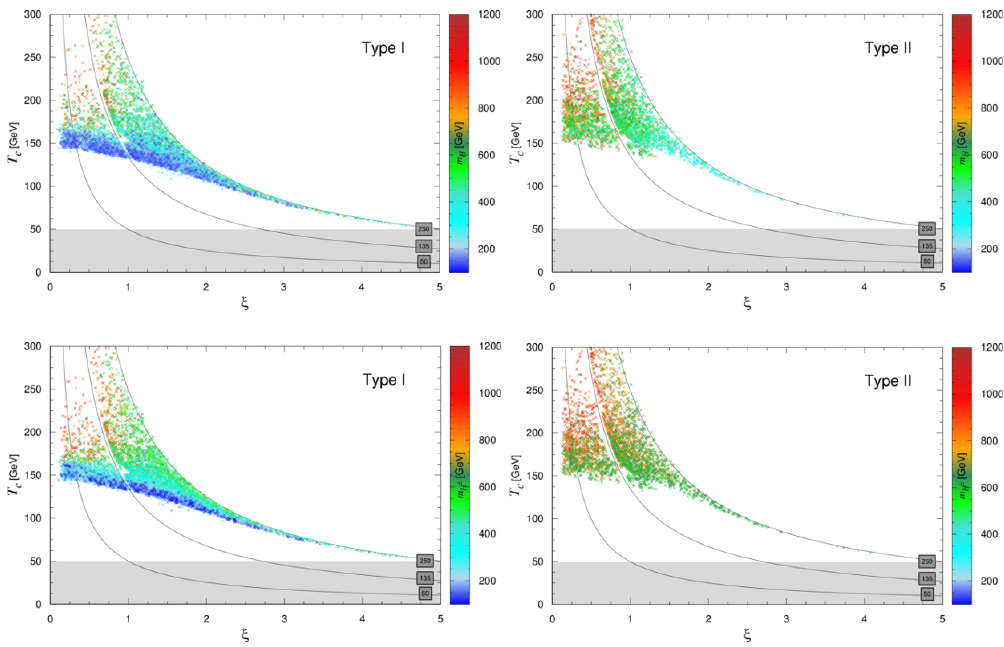
Figure 9 . Properties of (cid:12)rst order PT in the 2HDM. Only T c . 300 GeV points are retained. Three black contours from top to down correspond to v c = 250 ; 135 ; 50 GeV. The value of m H ; m color coded as indicated by the scales on the right of the plots in the upper and lower panel,